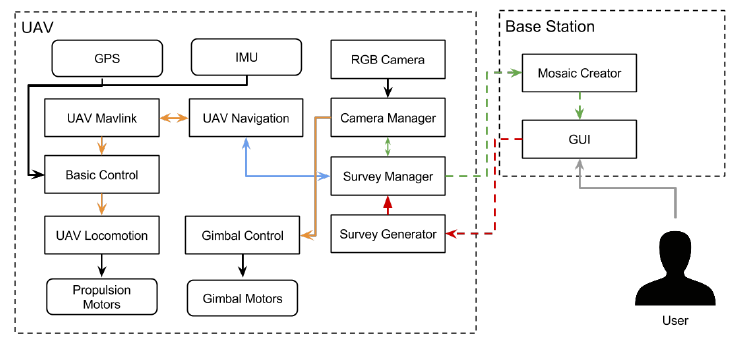
Figure 9. The UAV’s software architecture. The rounded rectangles depict low-level actuators and sensor, while the others depict the software modules. The red arrows depict messages with geo-referenced information, with the dashed line depicting the points that form the aerial survey area and the filled line the next point for the UAV. In green are depicted the images exchanged between the software modules; the filled line is the camera’s raw data and the dashed line the images used for the aerial mosaic. In orange are depicted the action messages and in black the sensor and actuator streams. The blue arrow depicts the action’s sent to the UAV’s navigation in order to perform the aerial